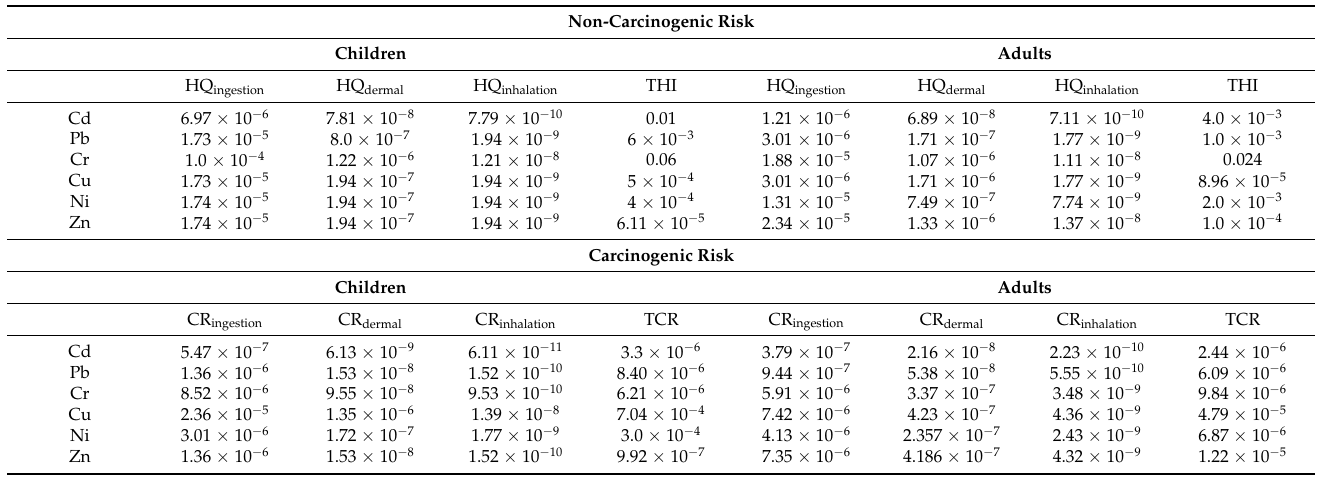
Table 7. Values of non-carcinogenic and carcinogenic risk for children and adults by different